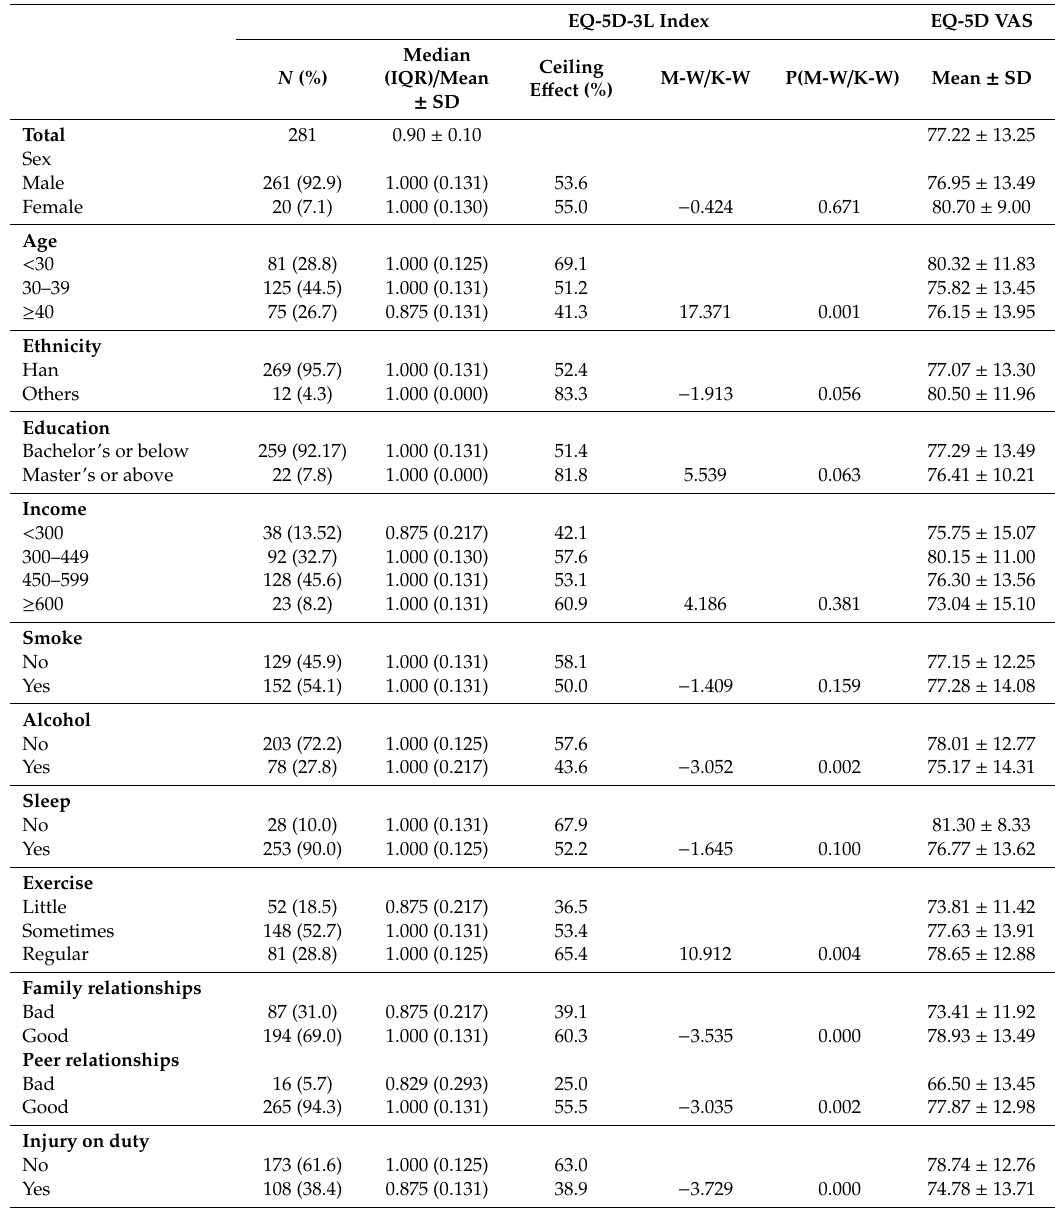
Table 1. Characteristics of respondents in the EQ-5D-3L index and EQ-5D